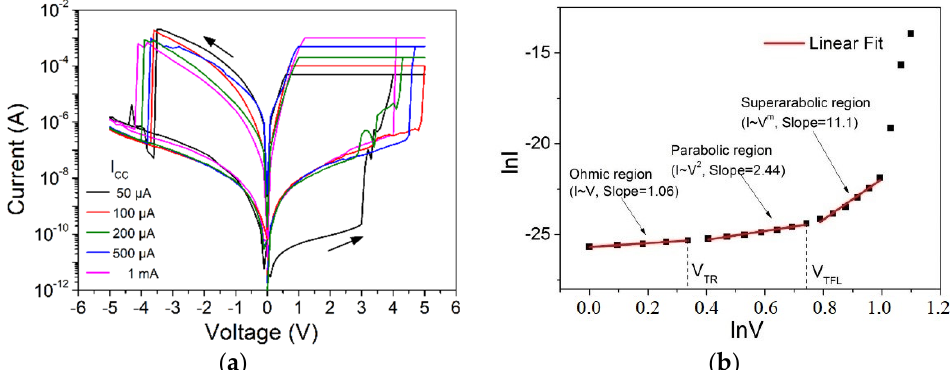
Figure 2. ( a ) Typical bipolar switching behavior for SiN x Memristor. Different resistance levels achieved under different current compliance values. ( b ) Analysis of typical I-V sweep characteristic for SiN x memristor during SET following the SCL conduction mechanism.